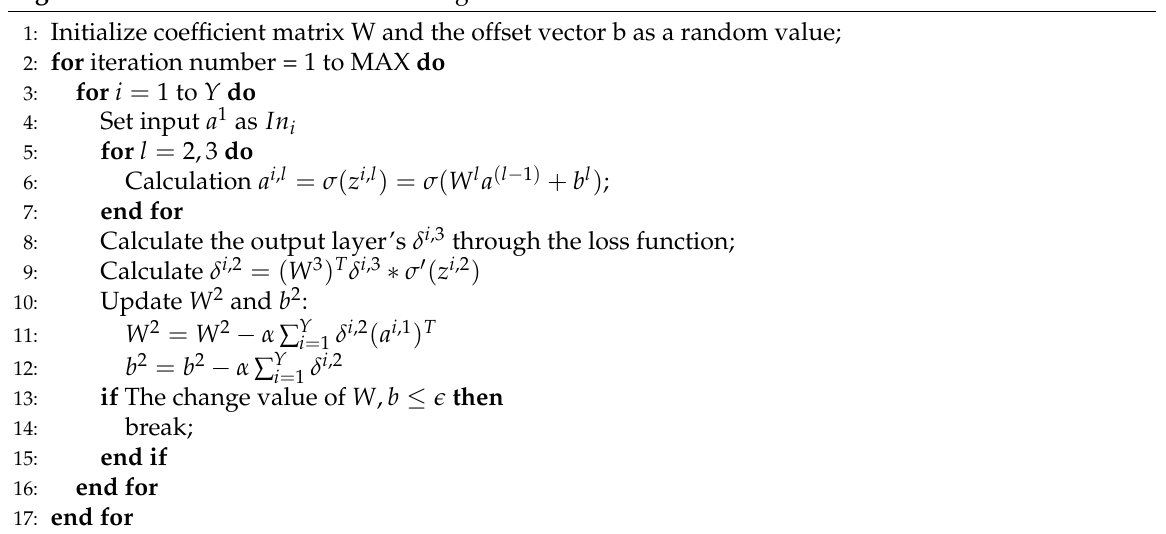
Algorithm 2. We use the batch gradient descent method. The input 10-dimensional vectors represent clock h , day of the week d , last time period request quantity r 0 , historical synchronous request quantity r 1 , r 2 , r 3 , r 4 , r 5 , r 6 , r 7 . Algorithm 2 BP Neural Network Training